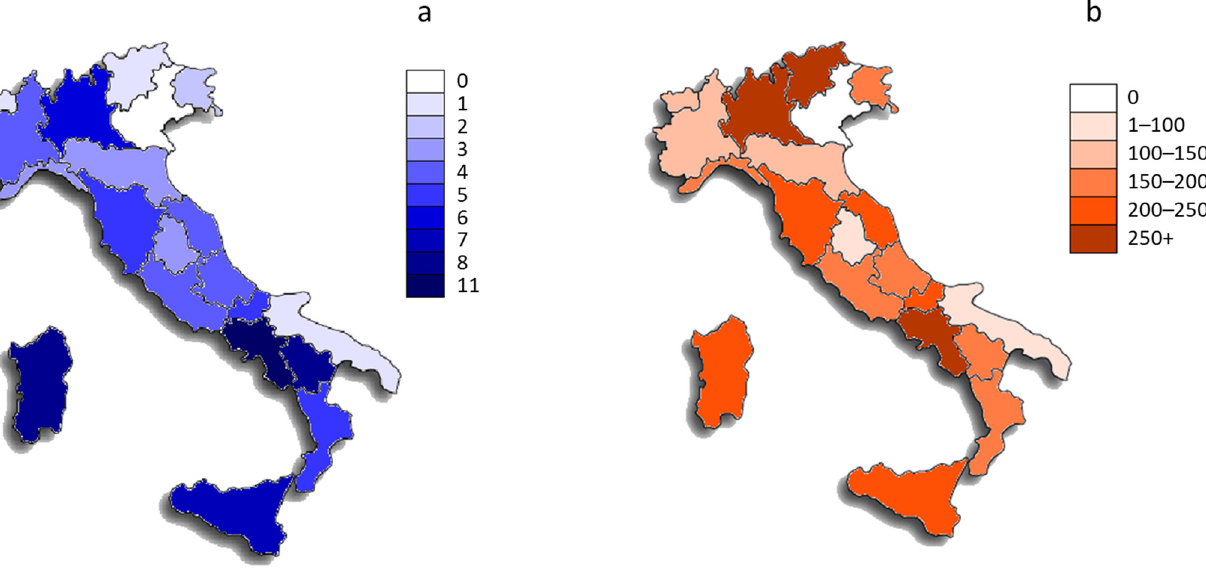
Figure 1. Maps showing the number of ethnobotanical studies that included medicinal applications ( a ) and the number of wild and cultivated plant species used for medicinal purposes ( b ) at the Italian regional level.